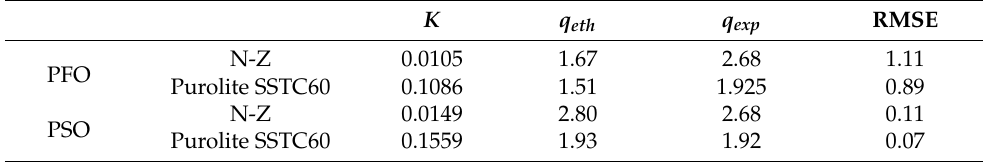
Table 2. Kinetic parameters for ammonium removal by N-Z and Purolite SSTC60.